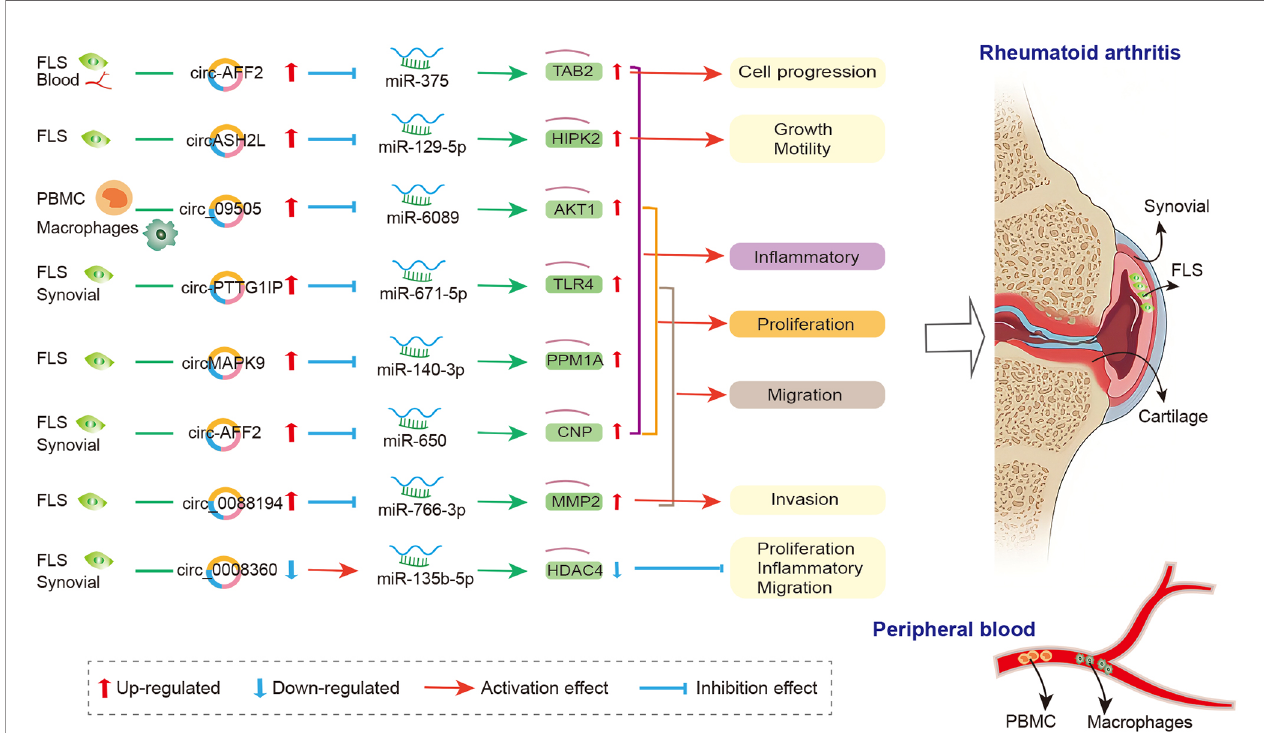
FIGURE 2 | The crosstalk of circRNA-miRNA-mRNA in RA. FLS, Fibroblast − like synoviocytes; PBMC, peripheral blood mononuclear cell; MMP2, matrix metalloproteinase-2; CNP, 2 ’ , 3 ’ -cyclic nucleotide phosphodiesterase; TAB2, binding protein 2; TLR4, toll-like-receptor 4; PPM1A, protein phosphatase 1A; HIPK2, homeodomain-interacting protein kinase 2; HDAC4, histone deacetylase